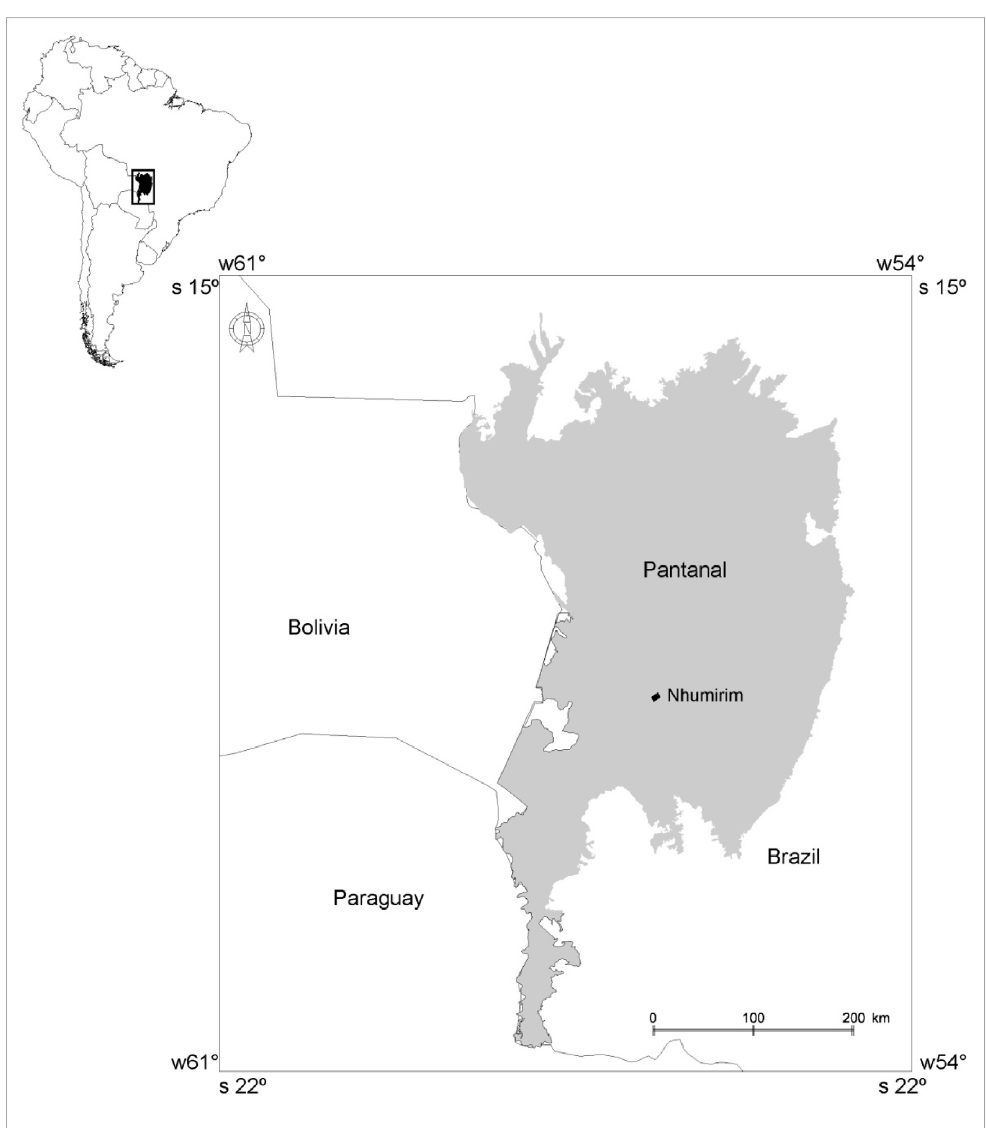
Fig 1. Location Nhumirim Ranch. Location in South America of the study area, Nhumirim Ranch (square), in Pantanal floodplain of Brazil.